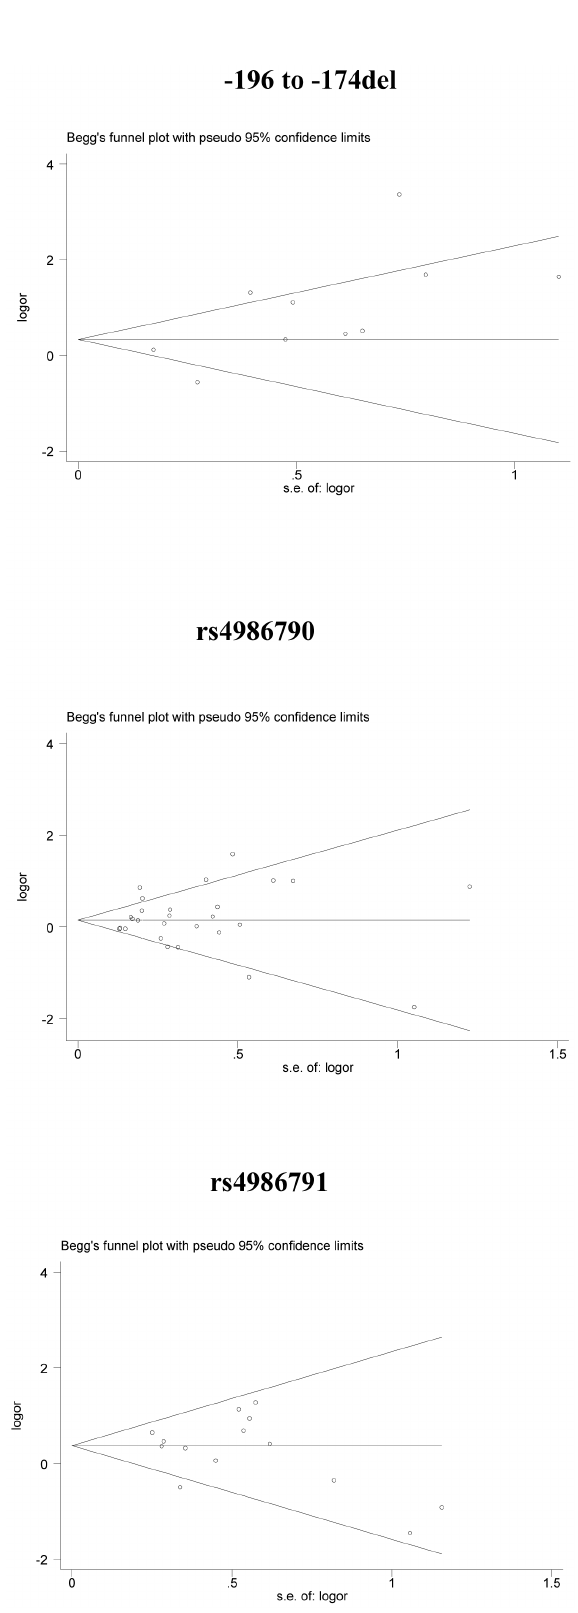
Figure 2. Begg’s funnel plot for publication bias test. Each point represents a separate study for the indicated association. s.e., standardized effect.